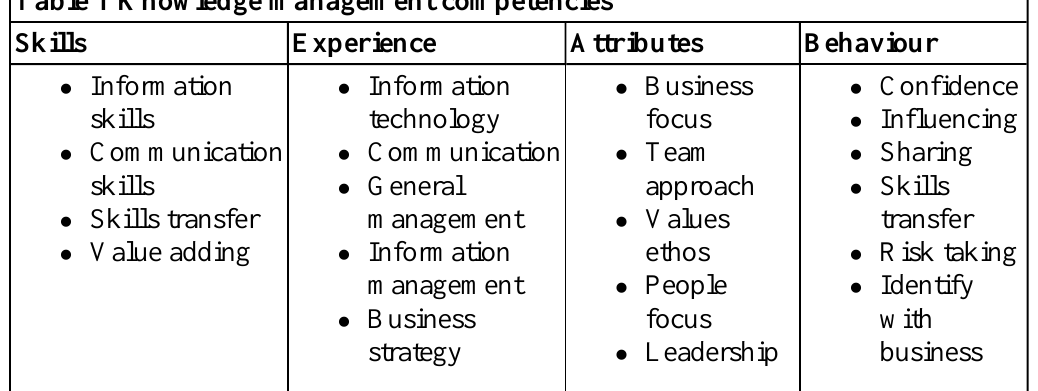
Table 1 Knowledge management